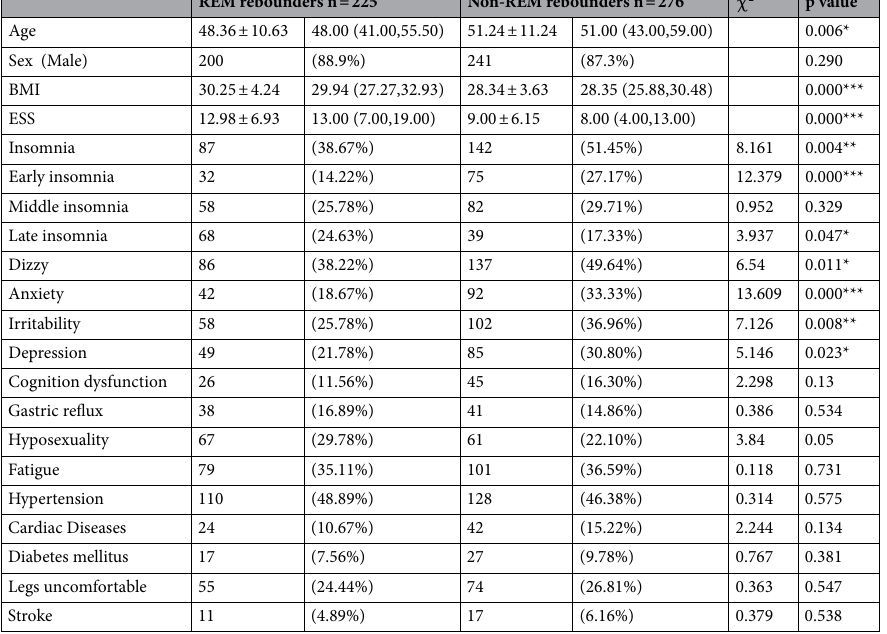
Table 2. The differences of clinical data between REM rebounders and non-REM